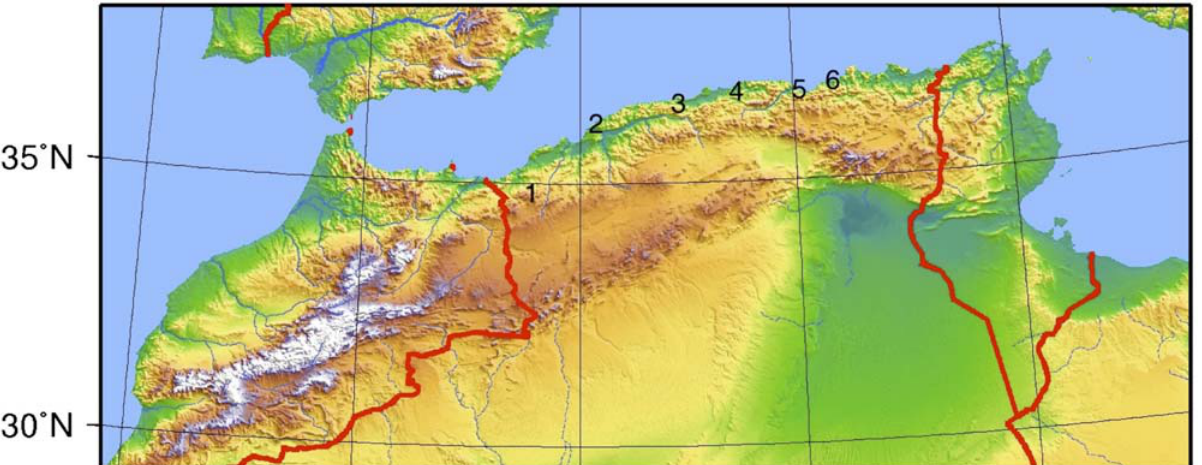
Fig 1. Location of localities sampled. 1 = Tlemcen, 2 = Mostaganem, 3 = Tipaza, 4 = Boumerdes, 5 = Bejaia, 6 =